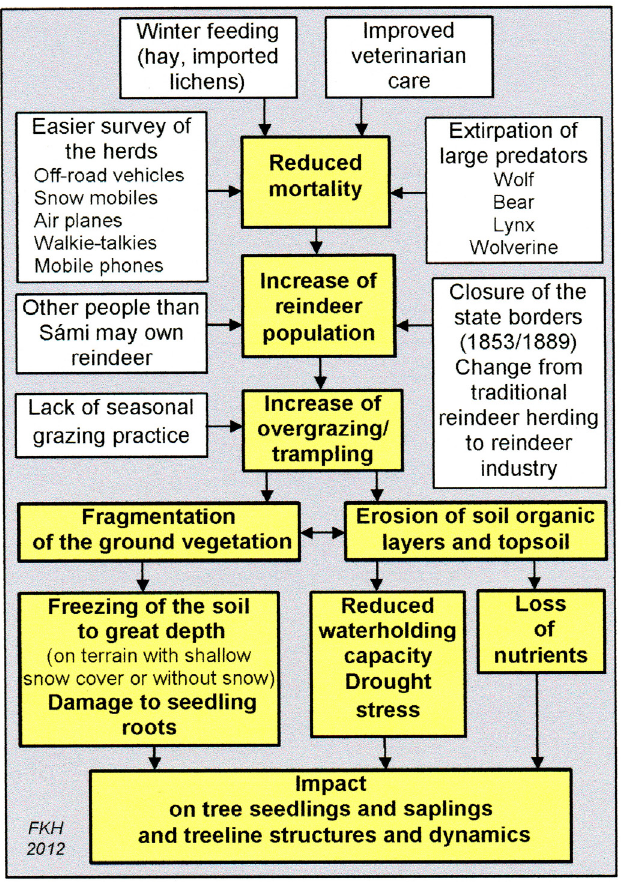
Figure 4: Causes (white boxes) of oversized reindeer population and its impact (yellow boxes) on treeline in northernmost subarctic Figure 5: Wind-eroded convex site in the birch-treeline ecotone on the N-facing slope of Koahppeloaivi (northern Finnish Lapland) at about 320 m elevation. Wind from the west (left hand side) prevails. The substrate is rapidly draining sandy-skeletal till. Wind-erosion was triggered by reindeer grazing and trampling. Where drifting snow accumulates, the original dwarf shrub cover (mainly Empetrum hermaphroditum and Betula nana ) still exists. Photo taken by the author, 6 July 1998.